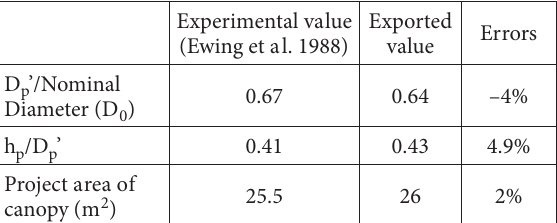
Figure 12 s hows t he m odel u sed in CFD sim ulation. ἀ e boundary conditions are the same as the test model